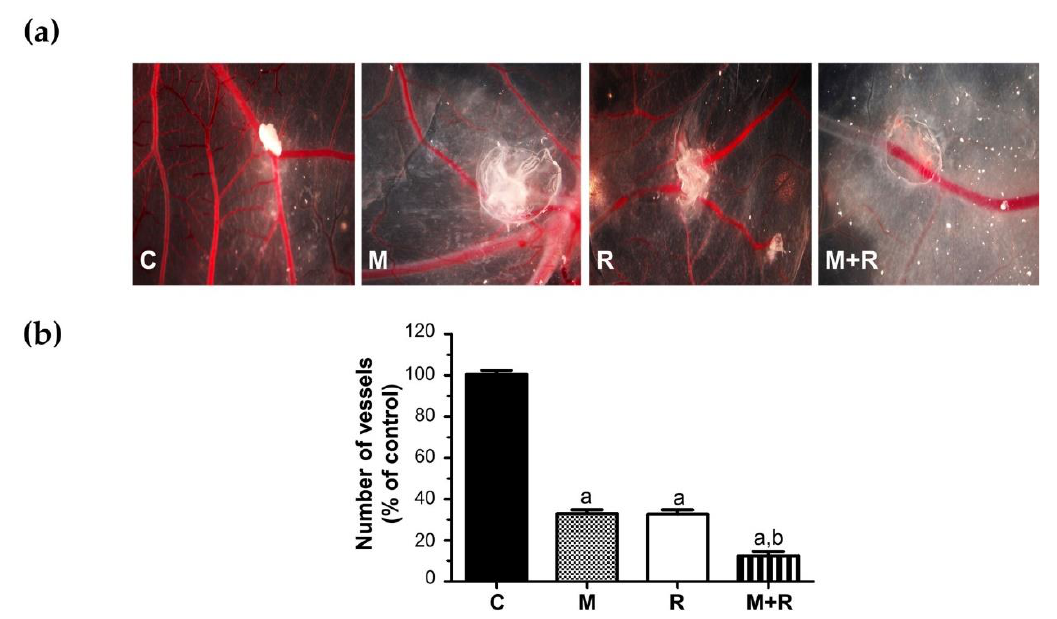
Figure 7. In vivo effect of melatonin pre-treatment on the radiation-induced actions on angiogenesis in the chorioallantoic membrane assay. MCF-7 cells pre-treated with melatonin and/or radiated were placed on the chorioallantoic membrane on day 11 of development. On day 14, newly formed blood vessels converging toward the alginates were counted at the microscopic level. ( a ) Representative images of CAM; ( b ) Vessel number data shown are expressed as mean ± S.E.M. a, p < 0.001 vs. C; b, p < 0.001 vs. R. C: Control; M: Melatonin pre-treated cells (1 nM); R: Radiated cells (8 Gy); M + R: Melatonin pre-treated and radiated cells.